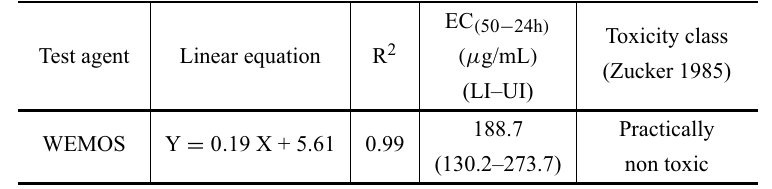
EC 50 value was obtained from three independent experiments and analyzed by the Trimmed Sperman-Karber method (Hamilton et al. 1979).